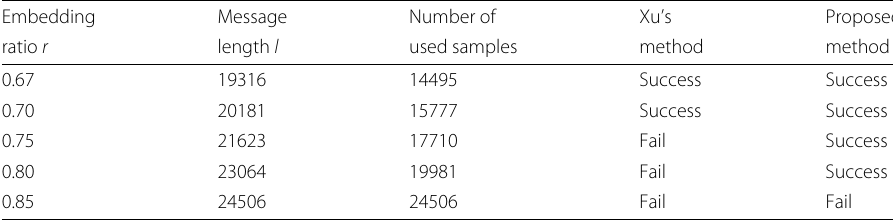
Table 4 Experimental results in the cases of large embedding ratios